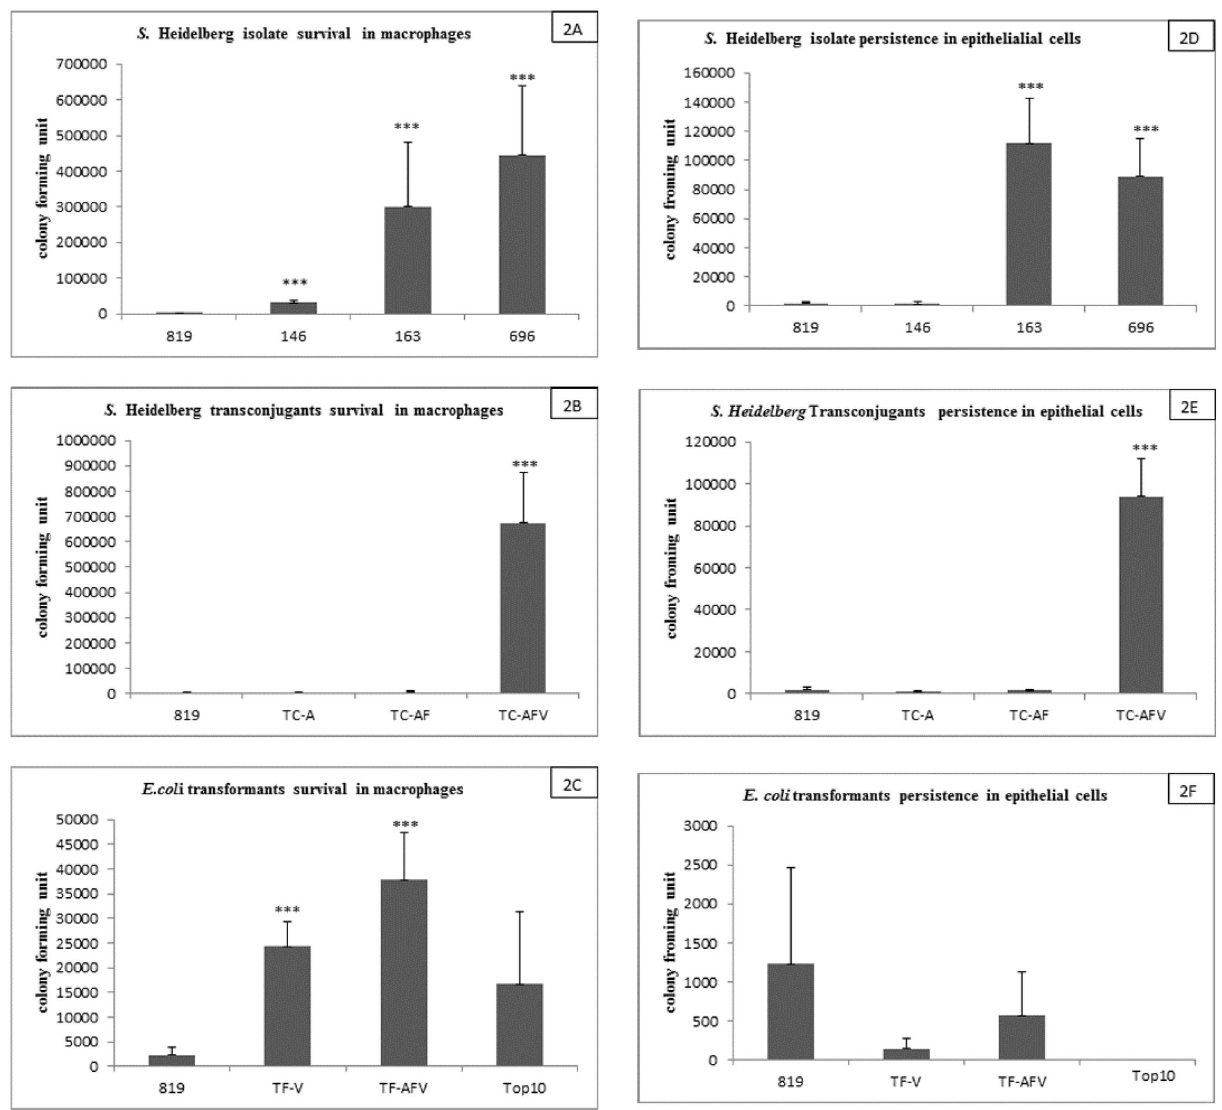
Figure 2. Bacterial survival assay to assess the bacterial survival mouse macrophages and epithelial cells were infected with S. Heidelberg strains (146, 163, 696), transconjugates and transformants that harbor transmissible plasmids and T4SS and strain that lacks both (819 and E. coli One Shot TOP10). Bacterial survival assays were performed 24 hr post infection. Panels A-C shows the survival in CFUs of S. Heidelberg isolates, transconjugants and transformants upon infection of macrophages. While panels D-F shows the number of CFUs during epithelial cell infection. Each data point represents the means and standard deviation for 5 individual